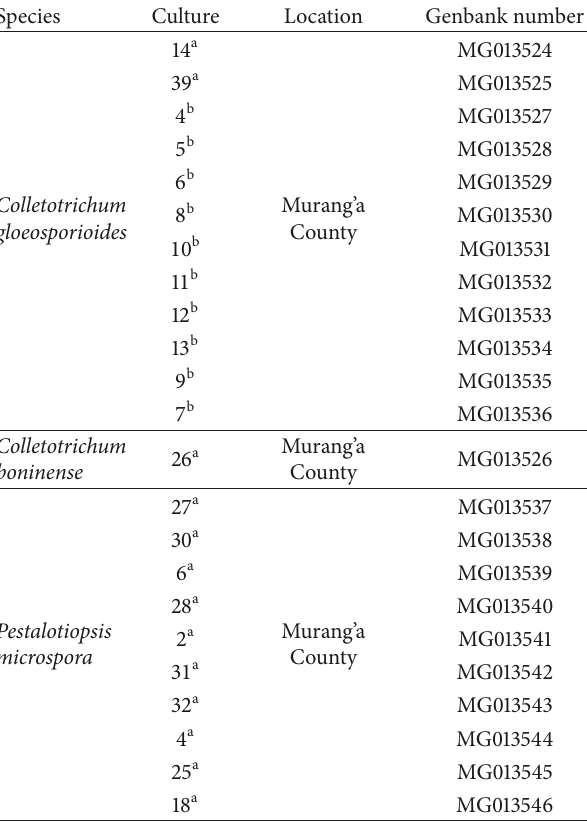
Table 4: Colletotrichum and Pestalotiopsis isolates with their Genbank accession